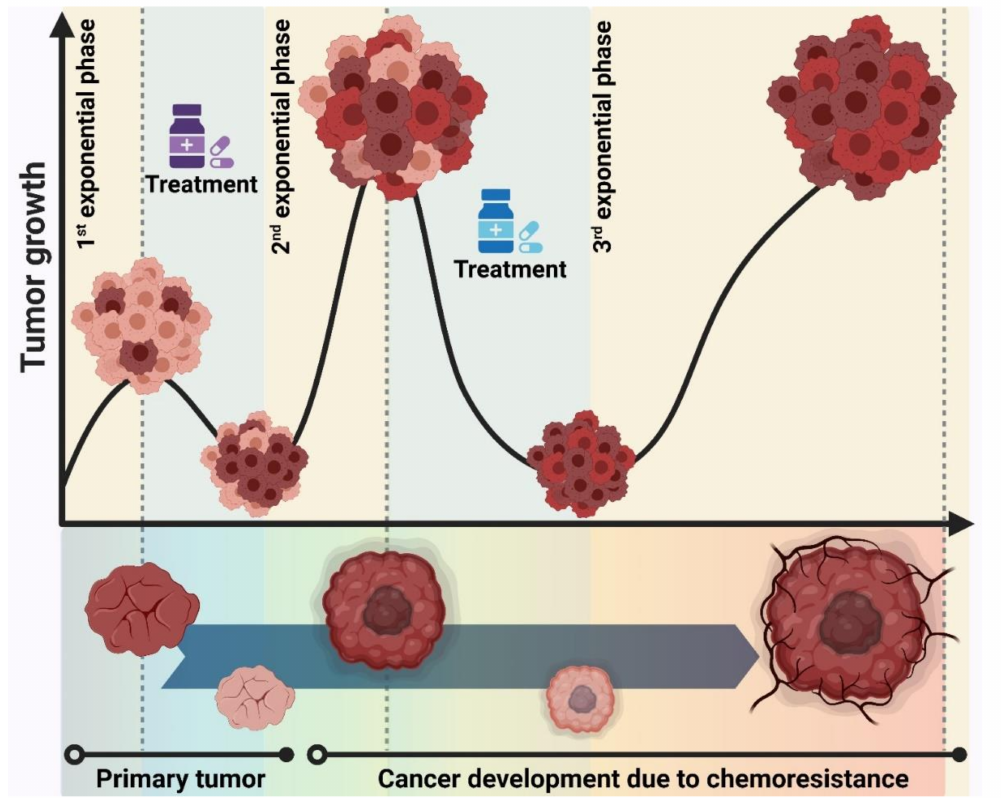
Figure 6. The Norton–Simon hypothesis describes the logical relationship between the tumor growth rate and chemoresistance phenomenon in cancer